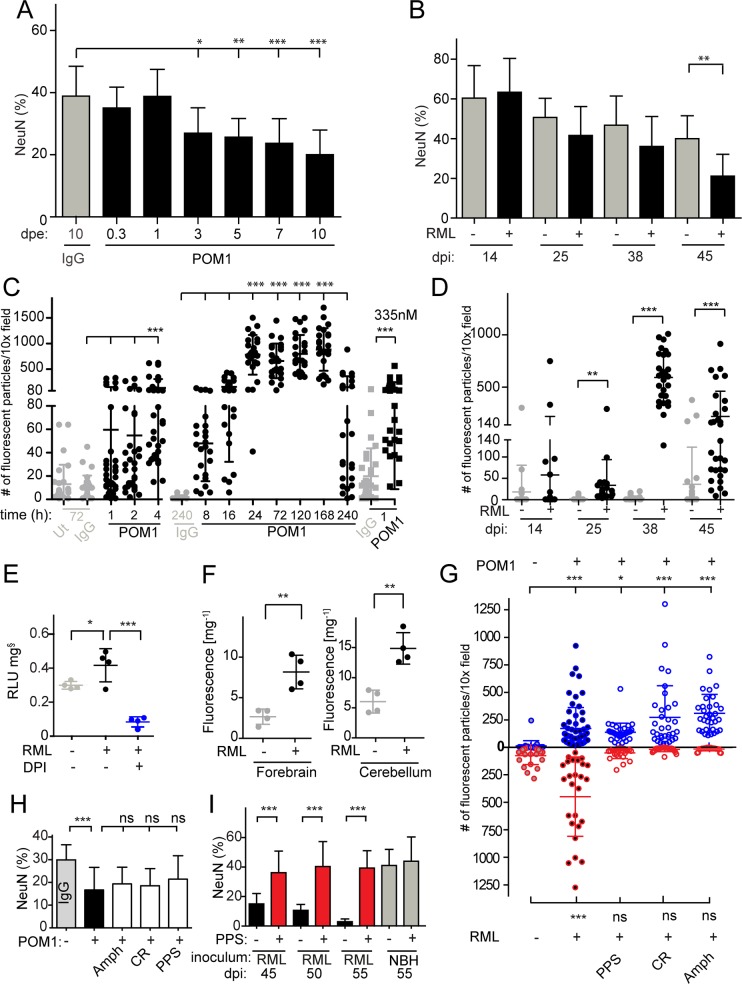
ROS is produced in both prion-infected and GDL-exposed COCS.(A) COCS were exposed to POM1 for 8 h-10 days, and neuronal loss was assessed by NeuN+ pixel coverage. Neuronal loss was significant at 3 dpe. Untreated slices (ut), or slices exposed to pooled IgG, were used as controls (grey). (B) In prion-infected COCS (+) neuronal loss became significant at 45 dpi. Controls (-): exposure to non-infectious brain homogenate. Data were analyzed using a two-tailed t-test; n = 9 biological replicates. (C—D) COCS were exposed to DHE, and the number of positive fluorescent particles was counted per 10x view field. (C) DHE conversion assays were performed at various time points between 1 h and 240 h. Data from three experiments are represented in this graph; n = 27 biological replicates. Slices that were untreated or exposed to pooled IgG were used as controls (grey). ROS production was detectable 4 hours after POM1 exposure and after 1 h with a higher POM1 concentration (335 nM). Here and henceforth data are presented as average ± s.d. and were analyzed by one-way ANOVA with Dunnett’s post-hoc test unless otherwise specified (***: p<0.001; **p<0.01; *p<0.05; n.s., not significant). Results of IgG vs POM1 at 335 nM were analyzed using a two-tailed t-test. (D) COCS were infected with RML (+) or exposed to non-infectious brain homogenate (-). DHE conversion assays were performed at various dpi. ROS production peaked at 38 dpi. Data were analyzed using a two-tailed t-test; n = 27 biological replicates. (E) RML-infected slices (42 dpi) were harvested and analyzed for ROS production by the lucigenin assay in the presence (blue) or absence (black) of DPI. DPI decreased superoxide-induced lucigenin conversion; n = 4 pools of 9 biological replicates. (F) DHE conversion was prominent in the forebrains and cerebella of terminally ill scrapie-infected tga20 mice. Data were analyzed using a two-tailed t-test; n = 4 mice. (G) The prion replication antagonists, PPS, CR and Amph, suppressed ROS production in prion-infected COCS (lower half), but not in GDL-exposed COCS (upper half); n = 27 biological replicates. (H) Treatment with PPS, CR, and Amph did not reduce cell death in GDL-treated COCS; n = 9 biological replicates. Neuronal viability was assessed here and henceforth by measuring the percentage of NeuN+ pixels (ordinate). (I) PPS treatment rescued cell death in RML-infected slices for ≥55dpi (red bars). Data were analyzed using a two-tailed t-test; n = 9 biological replicates.